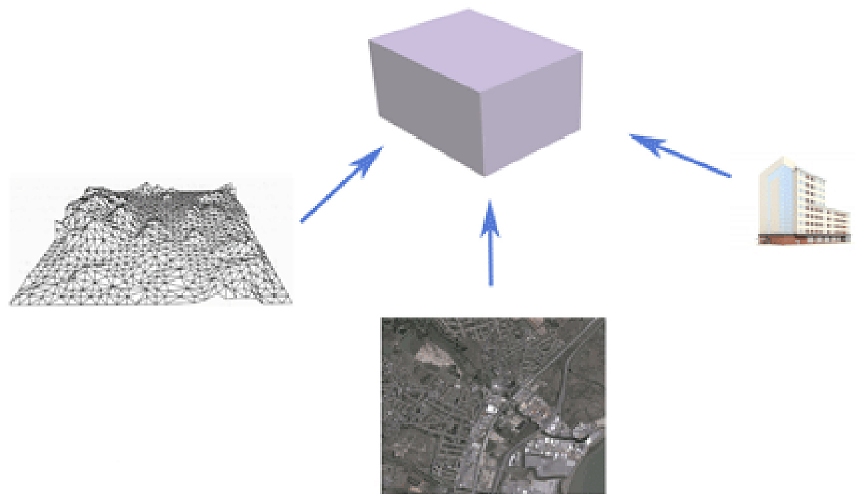
Figure 1. Geo-node